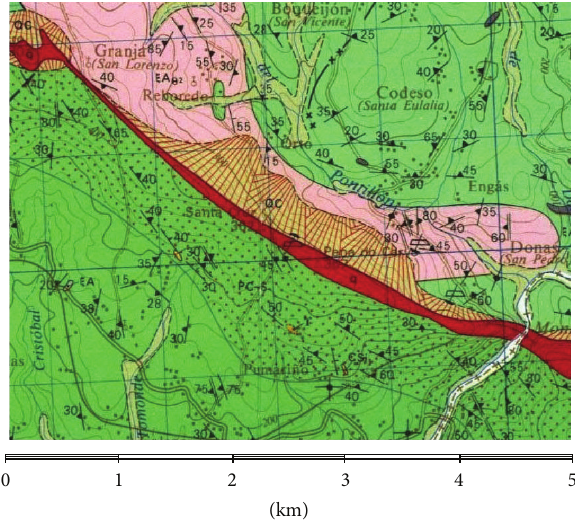
Figure 1: Geological map of the area where the quartz seam is located.